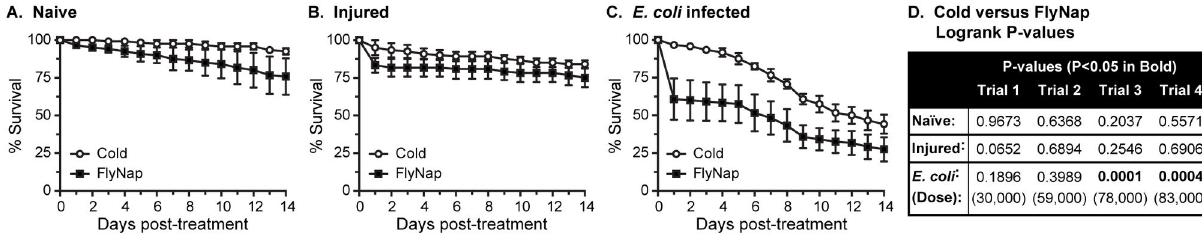
Figure 6. Effect of cold or FlyNap anesthesia on immune competence. Mosquitoes were anesthetized by exposure to cold or by exposure to FlyNap for 30 sec. A-C. Survival curves of naïve (A), injured (B) and E. coli infected (C) mosquitoes. The curves presented are the average of four trials composed of 30 mosquitoes per treatment group, and bars denote the standard error of the mean. D. LogRank P values comparing the cold and FlyNap survival curves for the treatment groups in all 4 independent trials. doi: